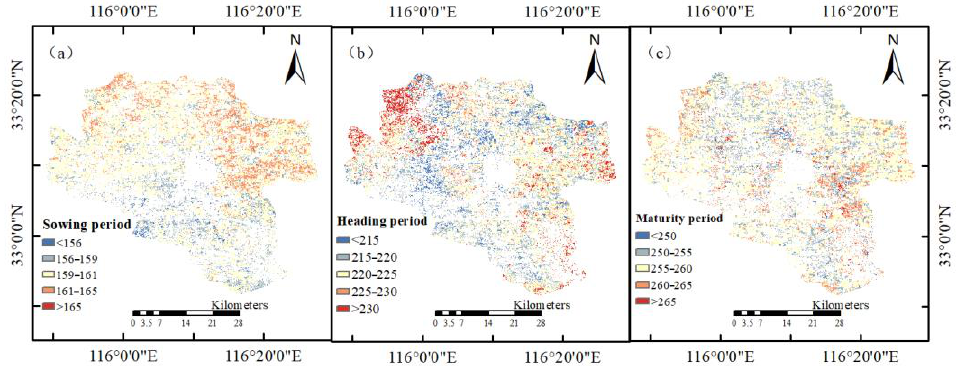
Figure 7. Spatial distribution of maize phenological periods in Lixin County, 2021. ( a ) Sowing period; ( b ) Heading period; ( c ) Maturity period.